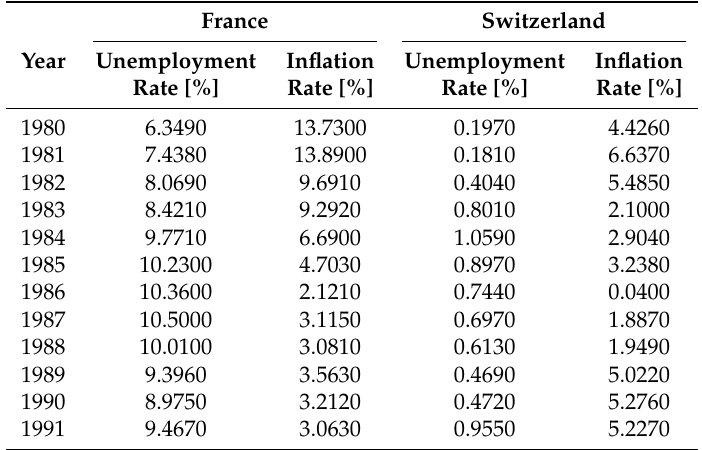
Table A1. The complete dataset: Econometric data for years 1980–2017